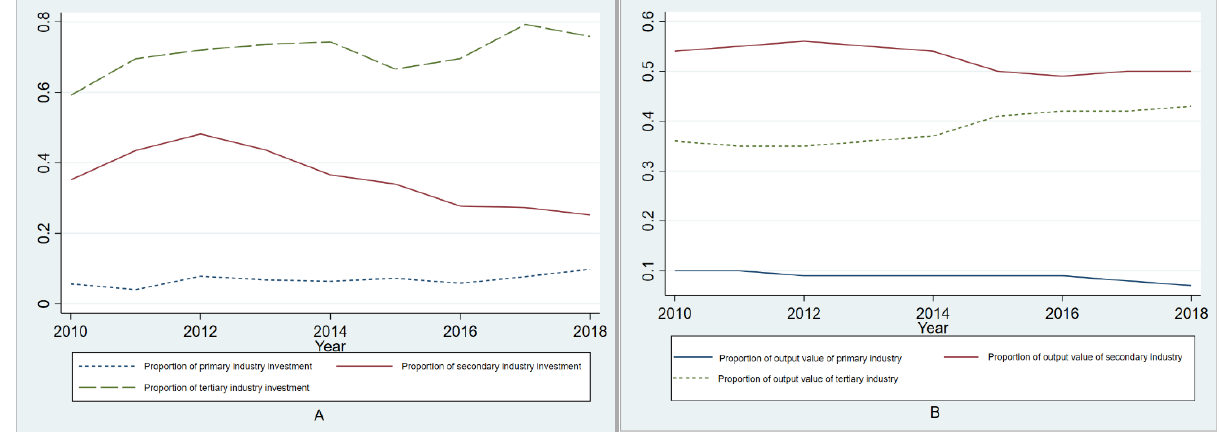
Figure 3. Proportion of investment, (A) denotes the proportion of investment in the tertiary industry in Shaanxi, and (B) denotes the proportion of investment in secondary industry in Shaanxi.